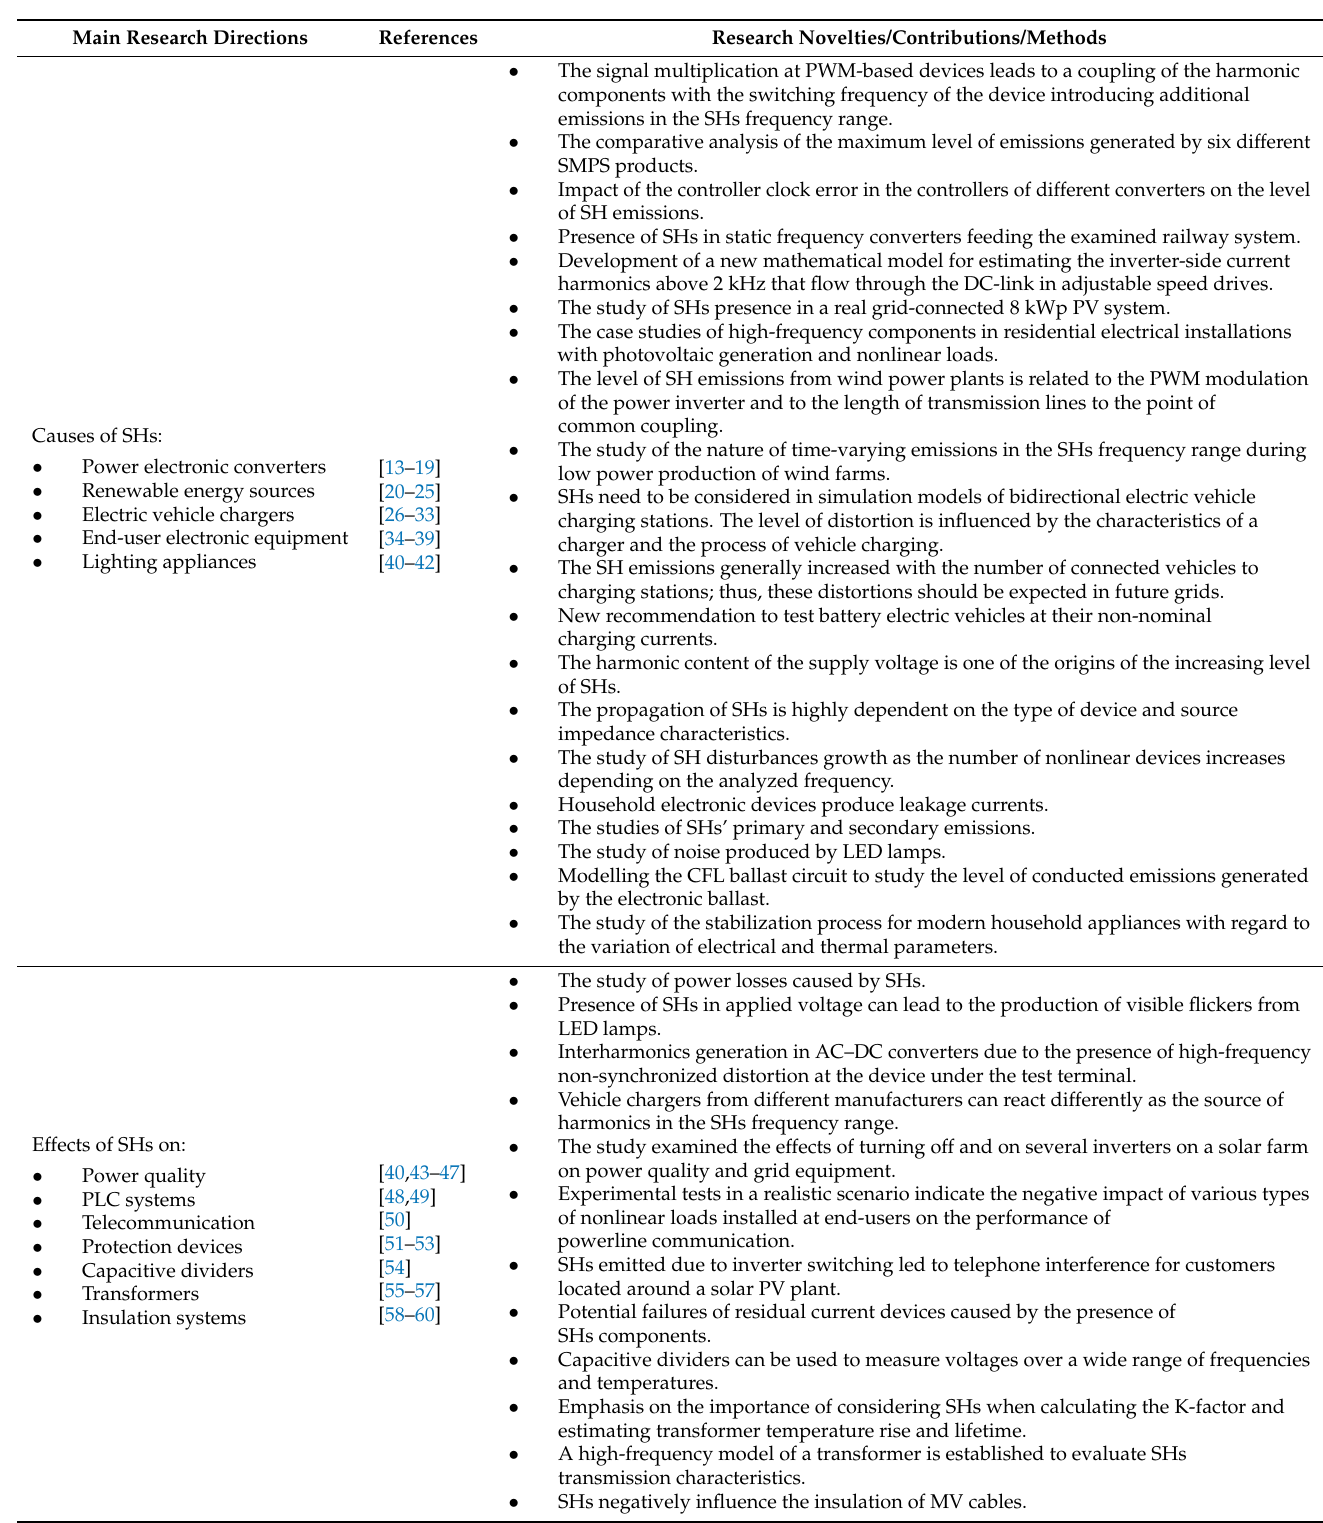
Table 1. Ongoing research directions and findings dealing with SHs emitted by nonlinear